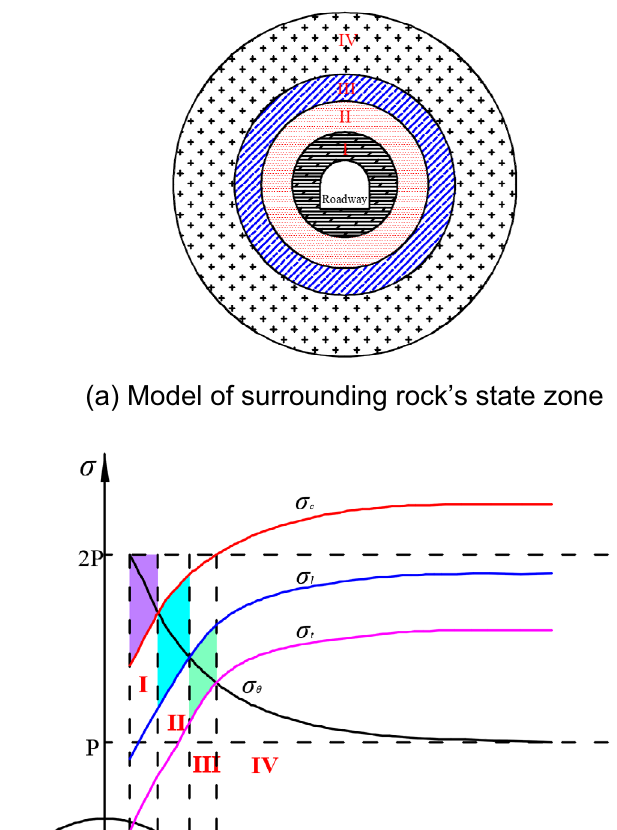
excavation of the roadway, the surrounding rock mass at the rib changes from the three-way compression state to the one-way compression state, and its strength decreases rapidly. On the other hand, the lateral confining pressure that the rock mass increases when going inside the surrounding rock. The corresponding strength of the surrounding rock continues to increase and eventually reaches a stable state. In Fig. 3b, the red, blue, and pink curves represent the developing rule of the ultimate strength, anti-perturbation strength, and creep threshold strength of the surrounding rock from the roadway rib into the pillar, respectively,. According to the relationship between the static concentrated stress on the surrounding rock and the different strengths of the engineering rock mass, four zones can be suggested: the fractured zone, perturbation sensitive zone, perturbation insensitive zone, and elastic zone. The stress state and deformation characteristics of the surrounding rock in each zone are different and are summarised as follows: I Fractured zone: In this zone, the large concentrated static stress exceeds the compressive ultimate strength σ c (shown in the purple area in Fig. 3b). As a result, of the rock mass. The stress relationship is σ θ ≥ a large number of internal cracks in the surrounding rock initiates, and the strength is reduced to the residual strength. After roadway excavation, the damage will occur in this zone within a short time, and the surrounding rock will lose its original bearing capacity.